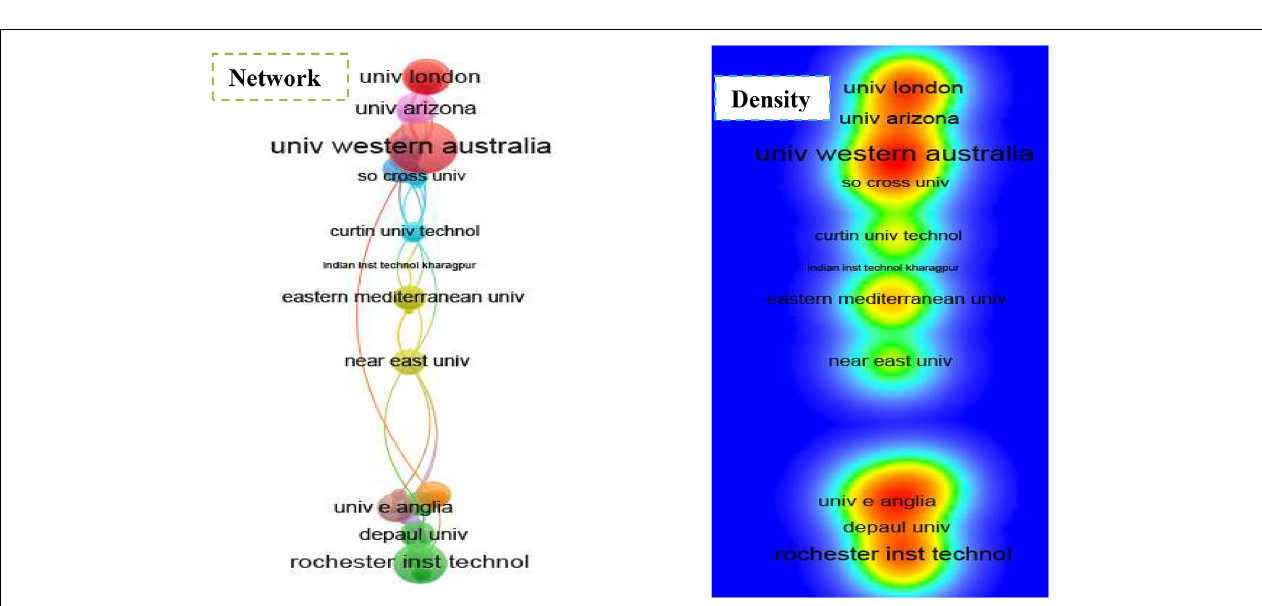
FIGURE 5 | The network and density of the countries with the highest reference in the field of quality in higher education.